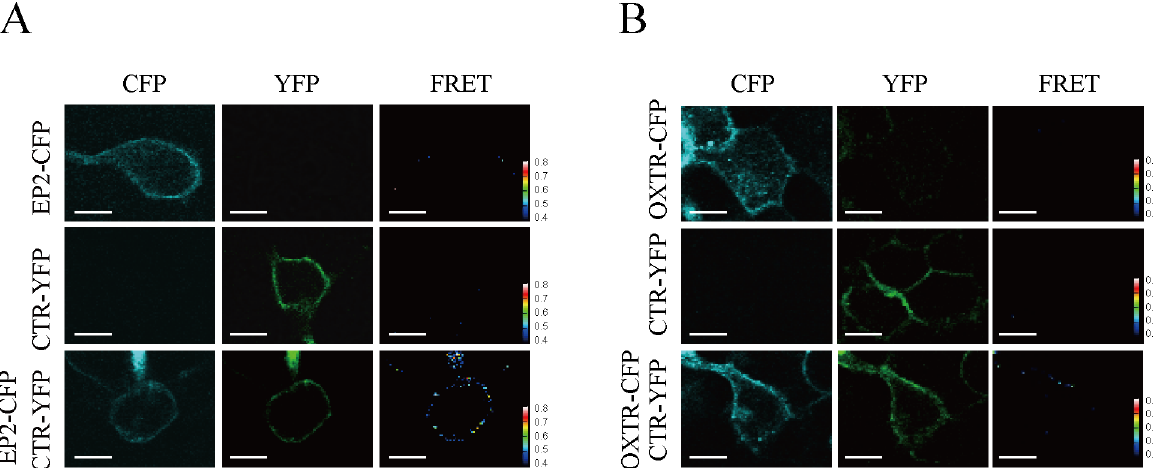
Fig 2. FRET analysis of EP2-CTR heterodimerization. EP2-CFP (A, upper panels)or OXTR-CFP (B, upper panels)and CTR-YFP (middle panels)were expressedindividually or coexpressed(lower panels)in HEK293MSR cells. Individualcells were imaged.Left panels,CFP; center panels,YFP; right panels, FRET. Specific FRET signal was detected in EP2-CFP- and CTR-YFP-expressingcells (A), but not in OXTR-CFP- and CTR-YFP-coexpressing cells (B). Color bar indicatesthe FRET ratio betweensignalintensitiesof YFP and CFP. Scale bar represents 10 μ